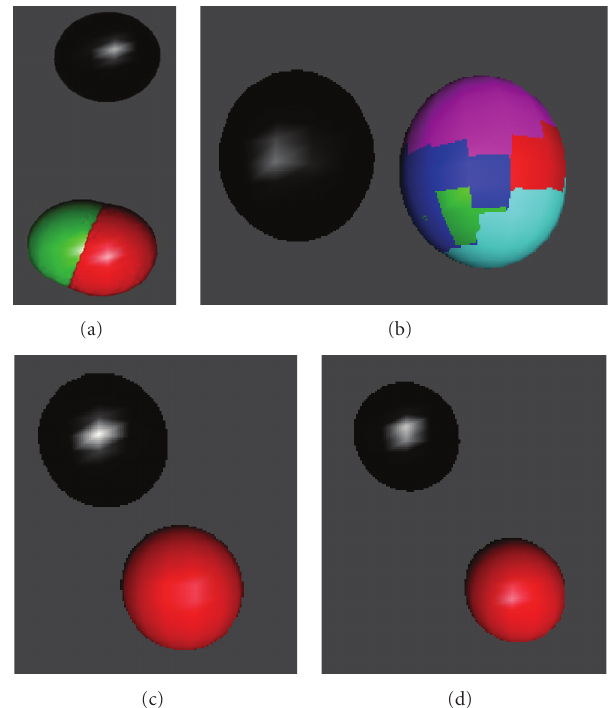
Figure 7: (a) Results of bootstrapped PCA examining di ff erences between ethogram data, corrected visitor data, and uncorrected visitor data when all questionnaires filled in by children were removed from the dataset. Black = ethogram data for group of otters, red = children’s questionnaires removed from corrected visitor data, and green = corrected visitor data. Cumulative proportion of variance explained by first 3 principal components > 0.999. (b) As above but examining visitor segments. Black = ethogram data for group of otters, red = corrected visitor data, green = visitors who had previous experience volunteering, dark blue = visitors who did not have prior experience volunteering, light blue = visitors who were members of a wildlife organisation, and pink = visitors who were not members of a wildlife organisation. Cumulative proportion of variance explained by first 3 principal components = 0.995. (c) As above but examining ethogram data for group of otters and corrected visitor data when playing and swimming were combined. Black = ethogram data for group of otters and red = corrected visitor data. Cumulative proportion of variance explained by first 3 principal components > 0.999. (d) As above but examining ethogram data and visitor data with standardised time periods. Black = ethogram data for group of otters and red = corrected visitor data. Cumulative proportion of variance explained by first 3 principal components =